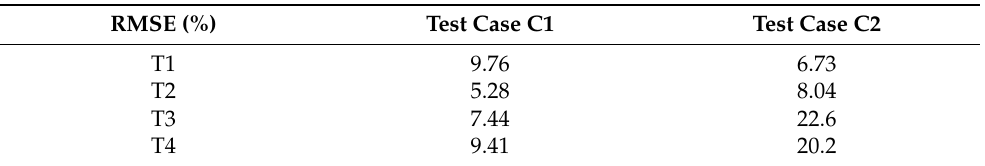
Table 3. RMSE (%) of the present numerical results with respect to the experimental measurements in Vincent and Briggs [24] and Briggs [23] for cases C1 and